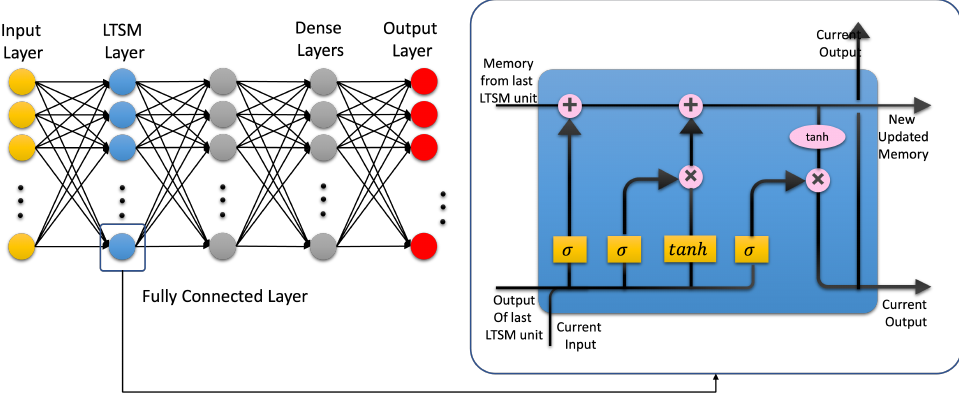
Figure 5. Recurrent neural network (RNN).